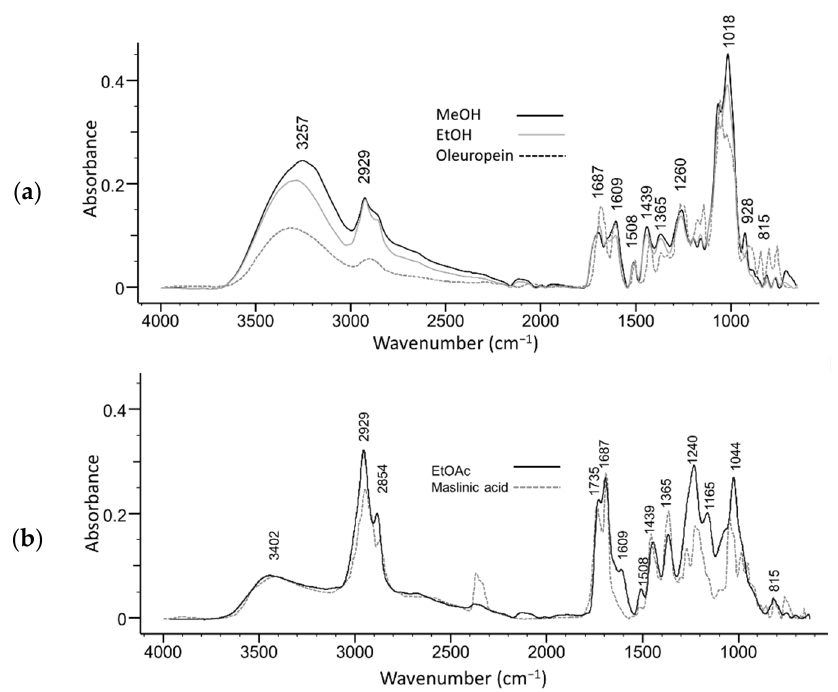
Figure 1. ATR-FTIR absorption spectra of unfermented olive leaves extracts in ( a ) methanol and ethanol compared to oleuropein, and ( b ) ethyl acetate compared to maslinic acid spectra.